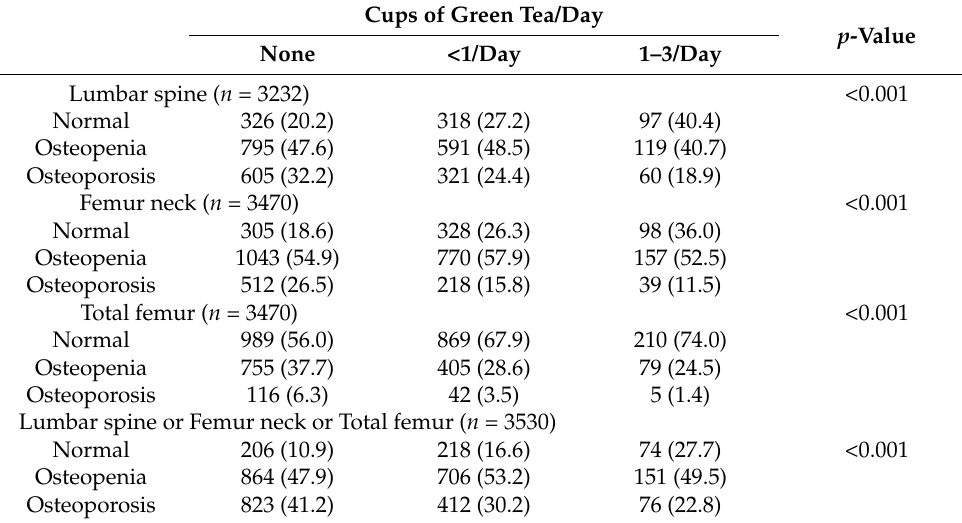
Table 2. Prevalence of osteoporosis and osteopenia with green tea intake.